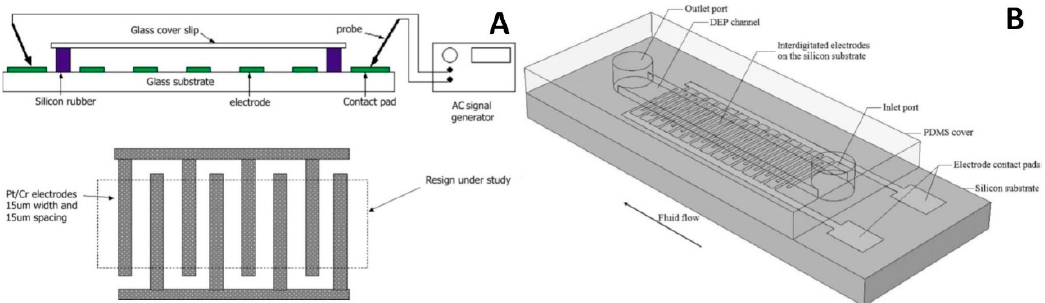
Figure 5. Devices with interdigitated electrodes. ( A ) Schematic of the system with simple particle manipulation and top view of electrodes. Reproduced with permission from [68], © 2002 Elsevier. ( B ) Drawing of the chip combining antibody recognition with DEP, thus improving the selectively of capturing bacteria. Reproduced with permission from [69], © 2006 RSC.